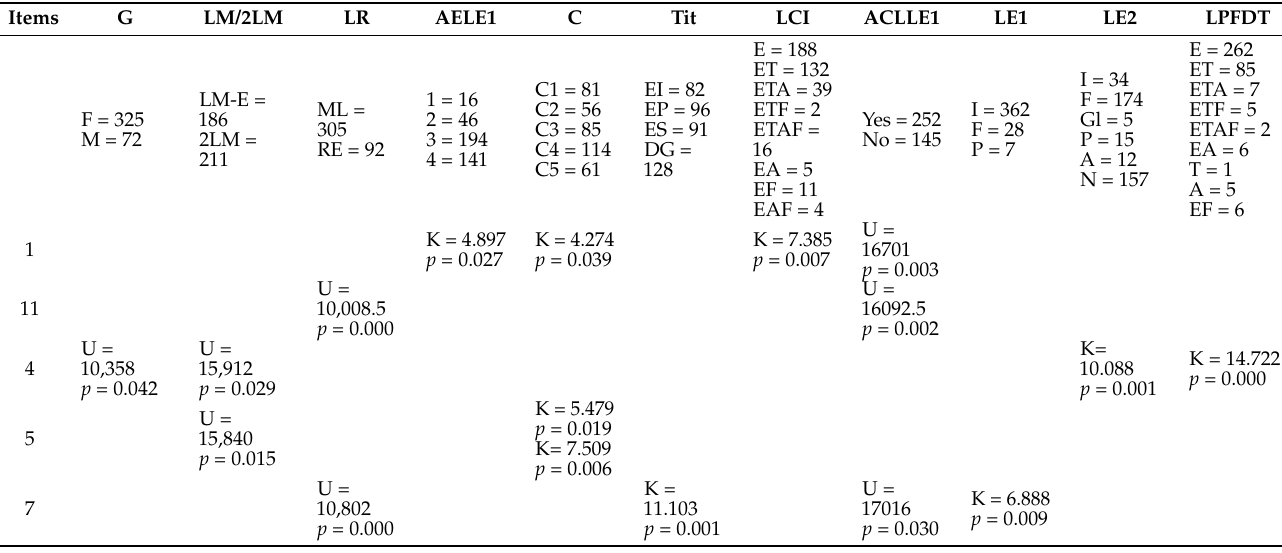
Table 5. Comparative statistics on Language learning